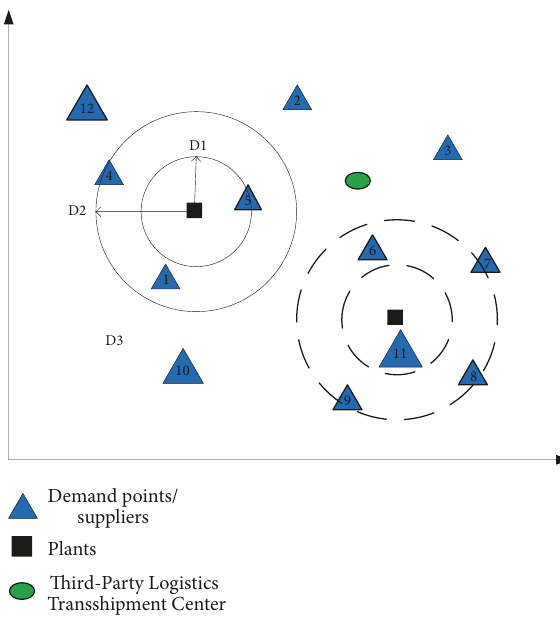
Figure 5: Logical model of multiplant